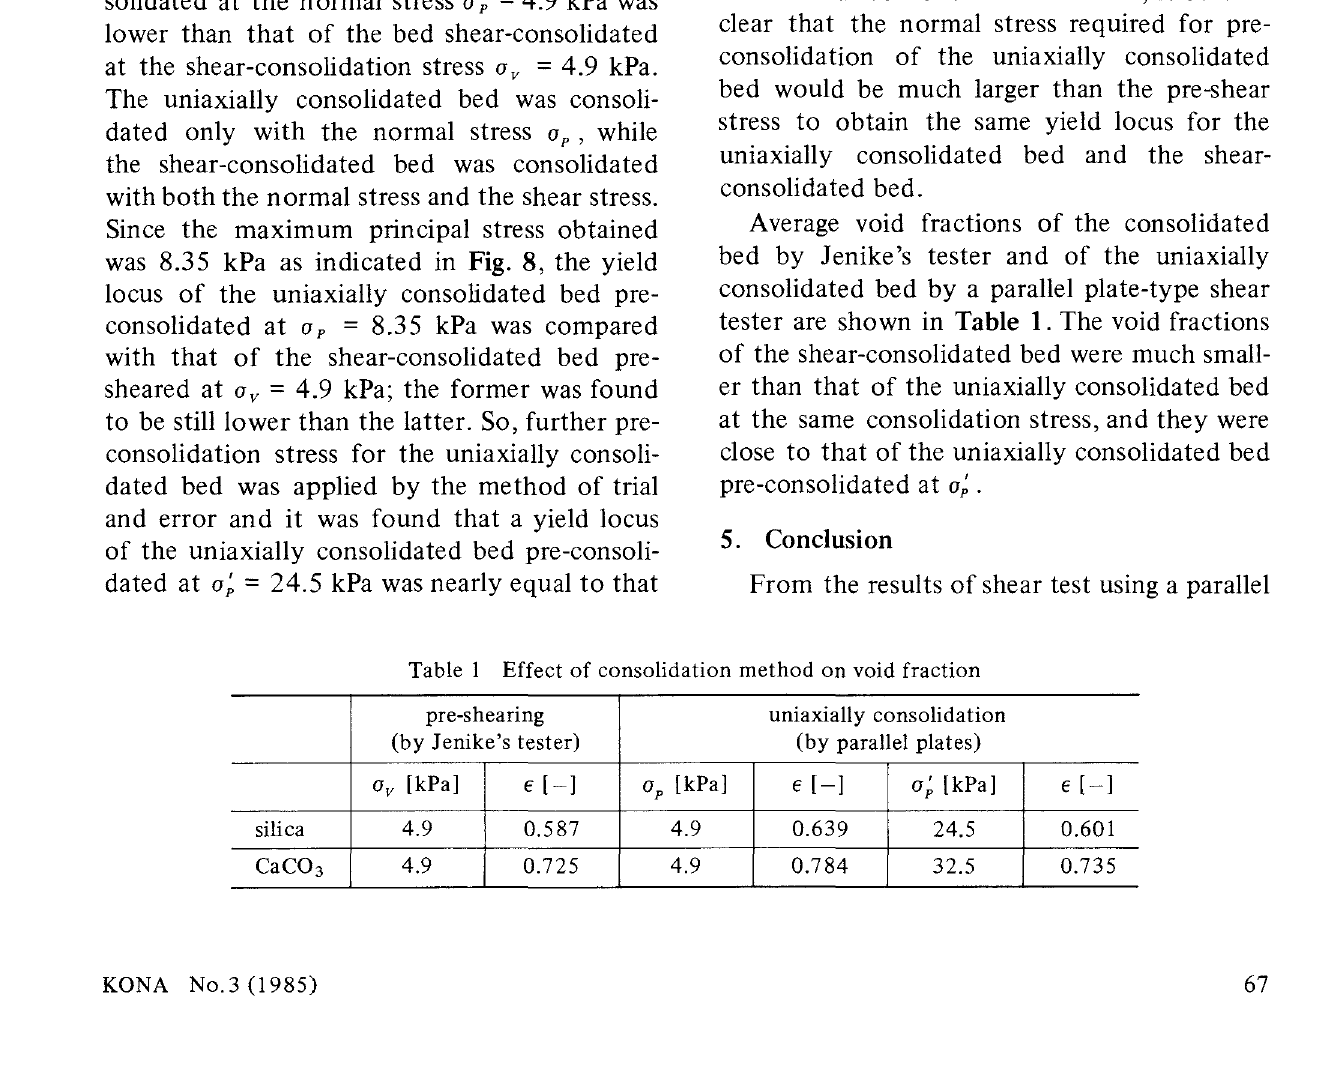
Table 1 Effect of consolidation method on void fraction